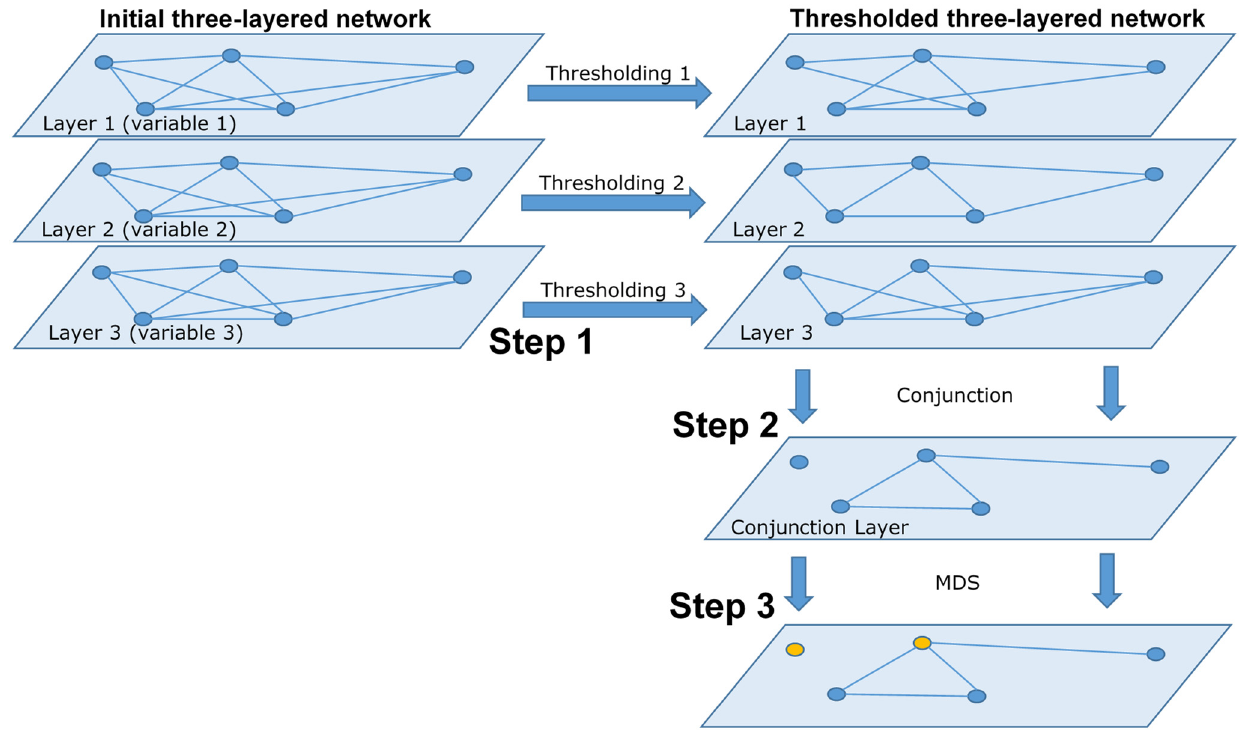
Figure 1. A graphic representation of the mT-MDS.